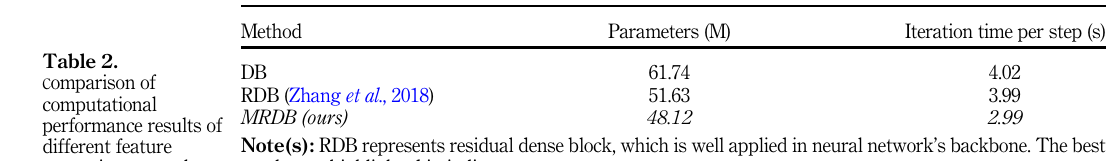
Table 1. Q uantitative results of 2DCNN,X2CT-GAN and MFCT-GAN